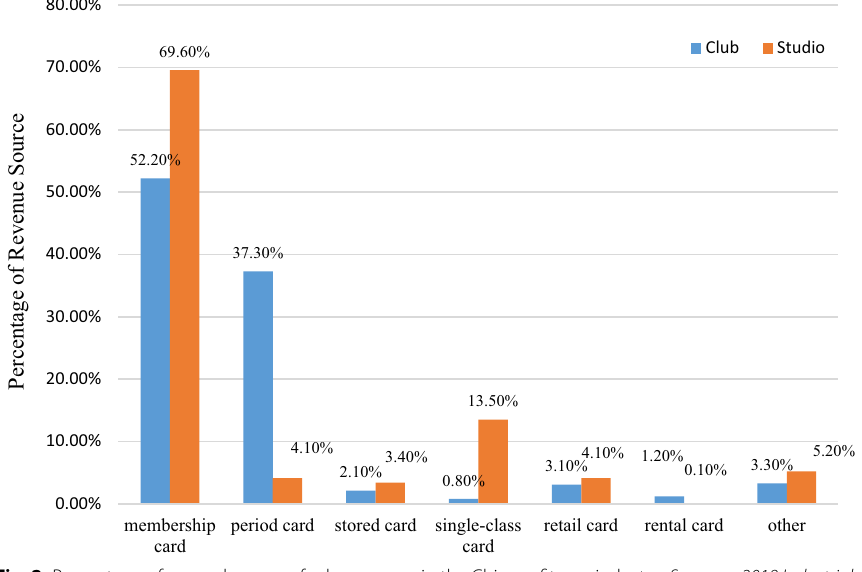
Fig. 2 Percentage of general source of sales revenue in the Chinese fitness industry Source: < 2018 Industrial Report of Chinese Fitness Industry: A White Book of Survival Guidance > , released in 2018 by SanTiYun Data Research Center, see https:// www. styd. cn/ defau lt/ data_ report